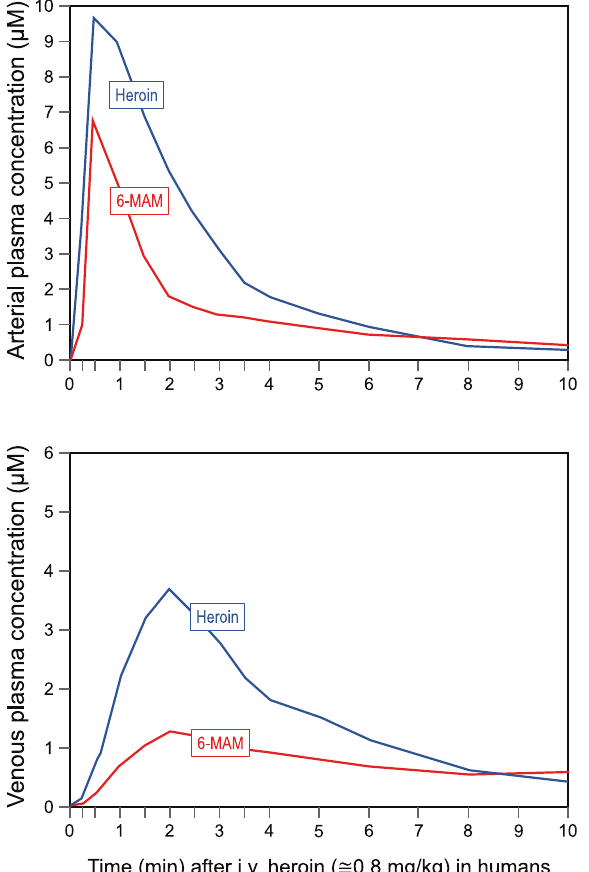
Fig. 2 Early pharmacokinetic pro fi le of heroin by i.v. administra- tion and metabolite 6-MAM. Time course of arterial and venous concentrations of heroin (blue line) and 6-MAM (red line), after an i.v. injection of heroin ( ≅ 0.8 mg/kg) in humans. Based on data extrapolated from Rentsch et al. 2001 [22].